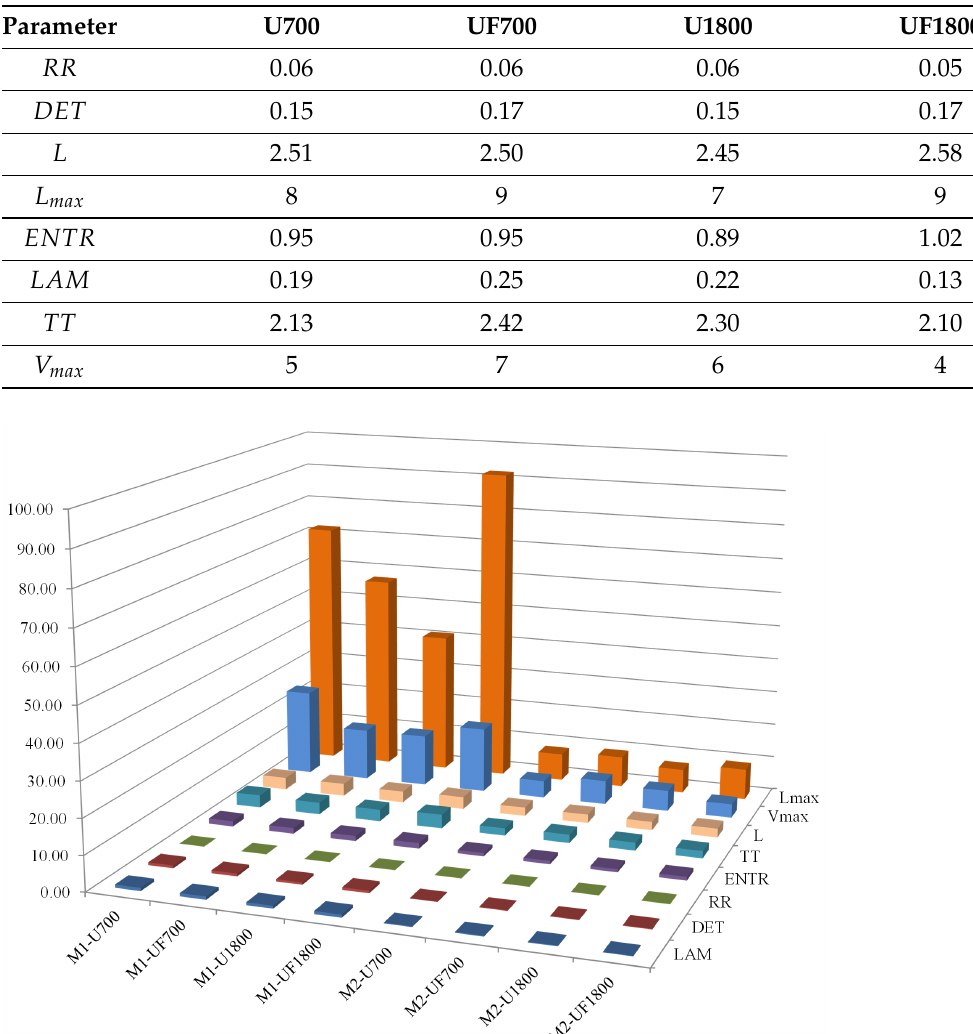
Table 4. Quantification of PSEMDI results.